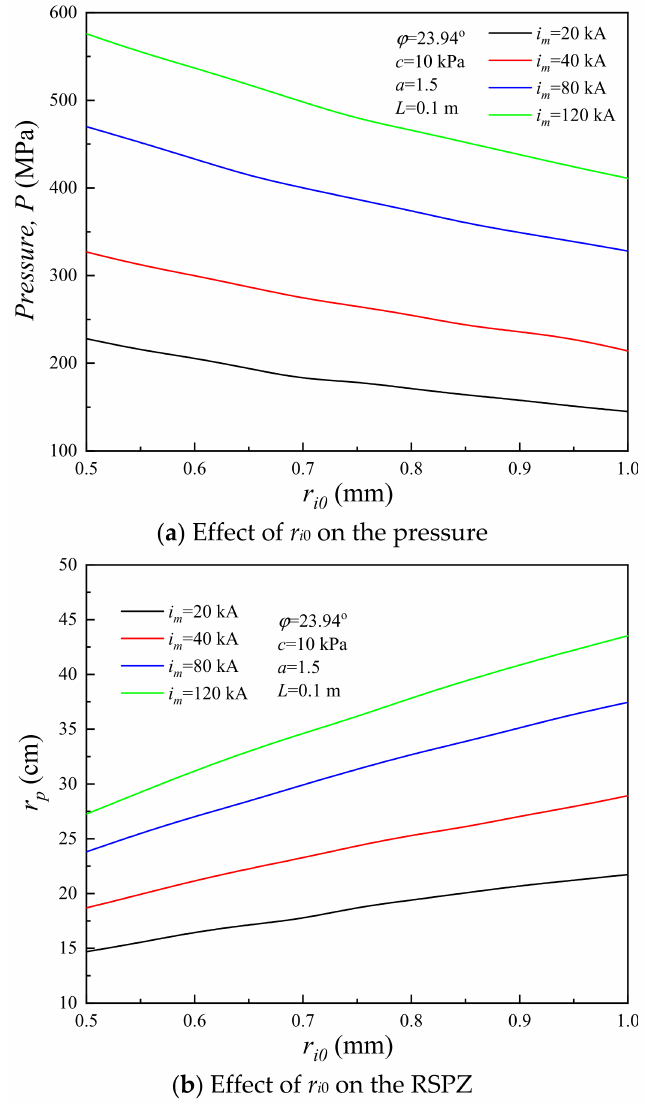
Figure 12. Influence of the initial radius of plasma